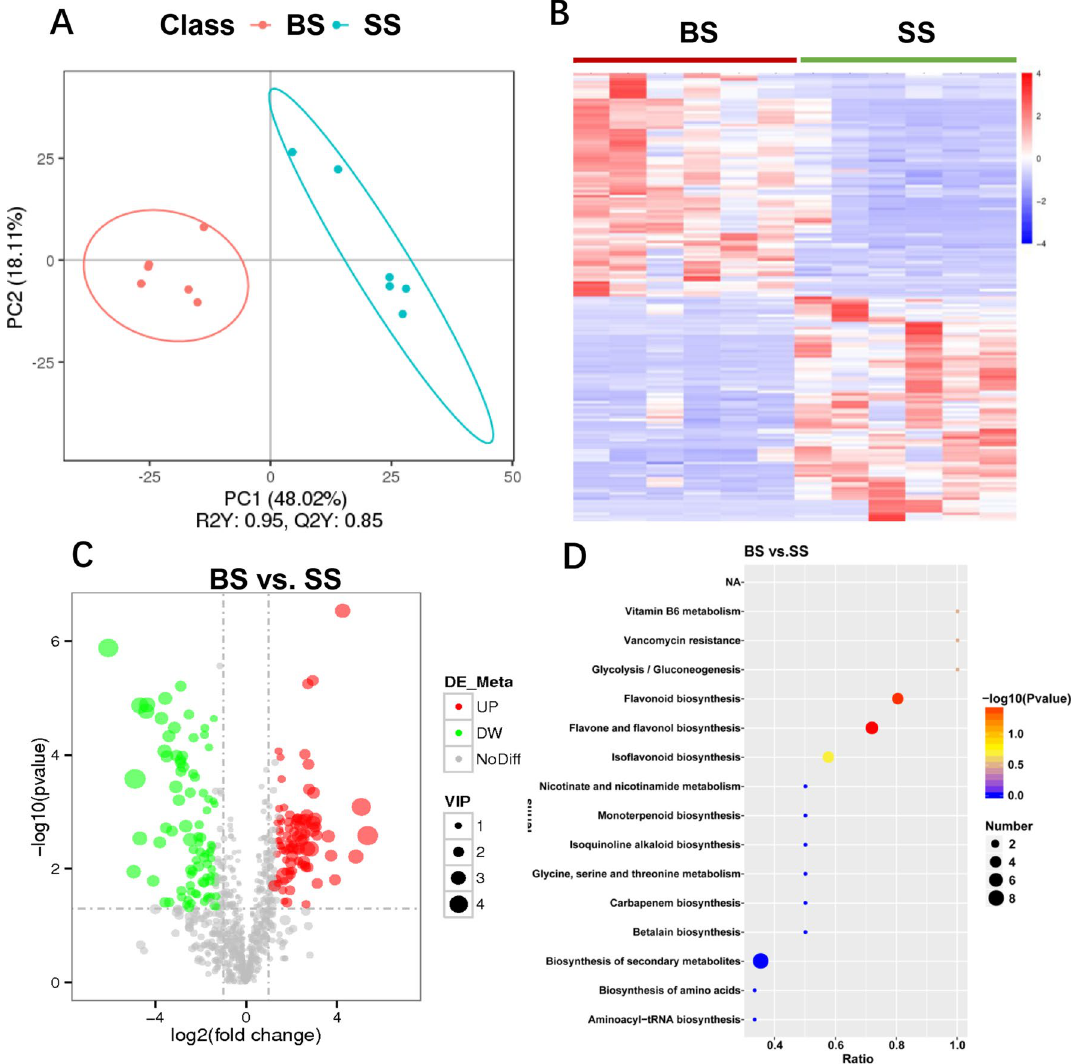
Figure 3. Important discriminatory metabolites identified by clustering, correlation and multivariate analysis between the BS and SS groups. ( A ) PLS-DA analysis displaying the grouped discrimination of the BS and SS groups by the first two PCs. ( B ) Hierarchical clustering analysis (HCA) for the BS and SS metabolites based on their z-normalized abundances. ( C ) Variable Importance in Projection (VIP) scores of the important discriminatory metabolites. ( D ) Scatter plot of top 15 KEGG pathway enrichment for differential metabolites in the BS and SS groups. Panel A was produced using metaX (v1, https ://githu b.com/wenbo star/metaX ), and panel A–D were produced using R (v3.4.3, https ://www.R-proje in BS, and 135 metabolites were significantly decreased (VIP > 1, P < 0.05). Among them, lamioside (62.94-fold increase), primisulfuron (57.93-fold increase), 3,5-dimethylpyrazin-2-ol (40.66-fold increase), sitaxentan (33.53- fold increase), crolibulin (26.50-fold increase), 2-formylpyridine (7.09-fold increase), (z)-desulfoglucotropeolin (6.45-fold increase), and asparagine (3.23-fold increase) were produced in greater concentrations in BS, while leucoside (67.59-fold decrease), isovitexin 2 ″ - O -arabinoside (29.84-fold decrease), vaccarin (25.65-fold decrease), kuromanin (21.22-fold decrease), and robinin (20.61-fold decrease) were greatly reduced in BS relative to SS (VIP > 3, P < 0.05). Through KEGG pathway annotation, 194 metabolites of these 247 distinct metabolites were mapped onto 13 different KEGG metabolic pathways, including amino acid metabolism, metabolism of cofactors and vita- mins, metabolism of terpenoids and polyketides, and biosynthesis of other secondary metabolites. However, the KEGG-enrichment scatterplot showed that there were only two distinguishing pathways including flavonoid biosynthesis, flavone and flavonol biosynthesis which were significantly enriched in BS compared to SS ( P < 0.05; Fig. 3D). Therefore, 22 distinct metabolites were selected from these two KEGG pathways for correlation analysis, including vitexin, naringin, apigenin, hesperetin, rhoifolin, and chlorogenic acid (Table 1).